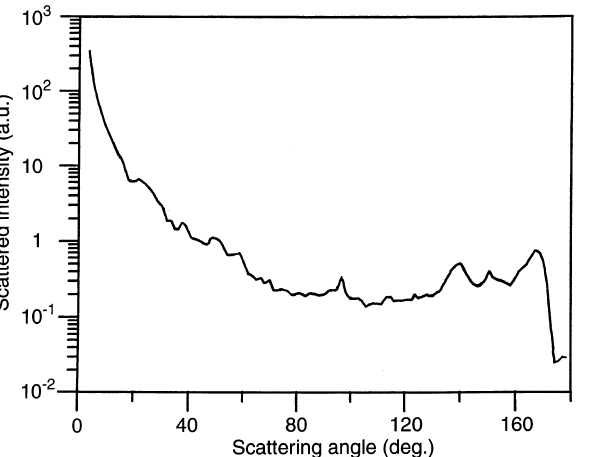
Fig. 13. Size distribution corresponding to